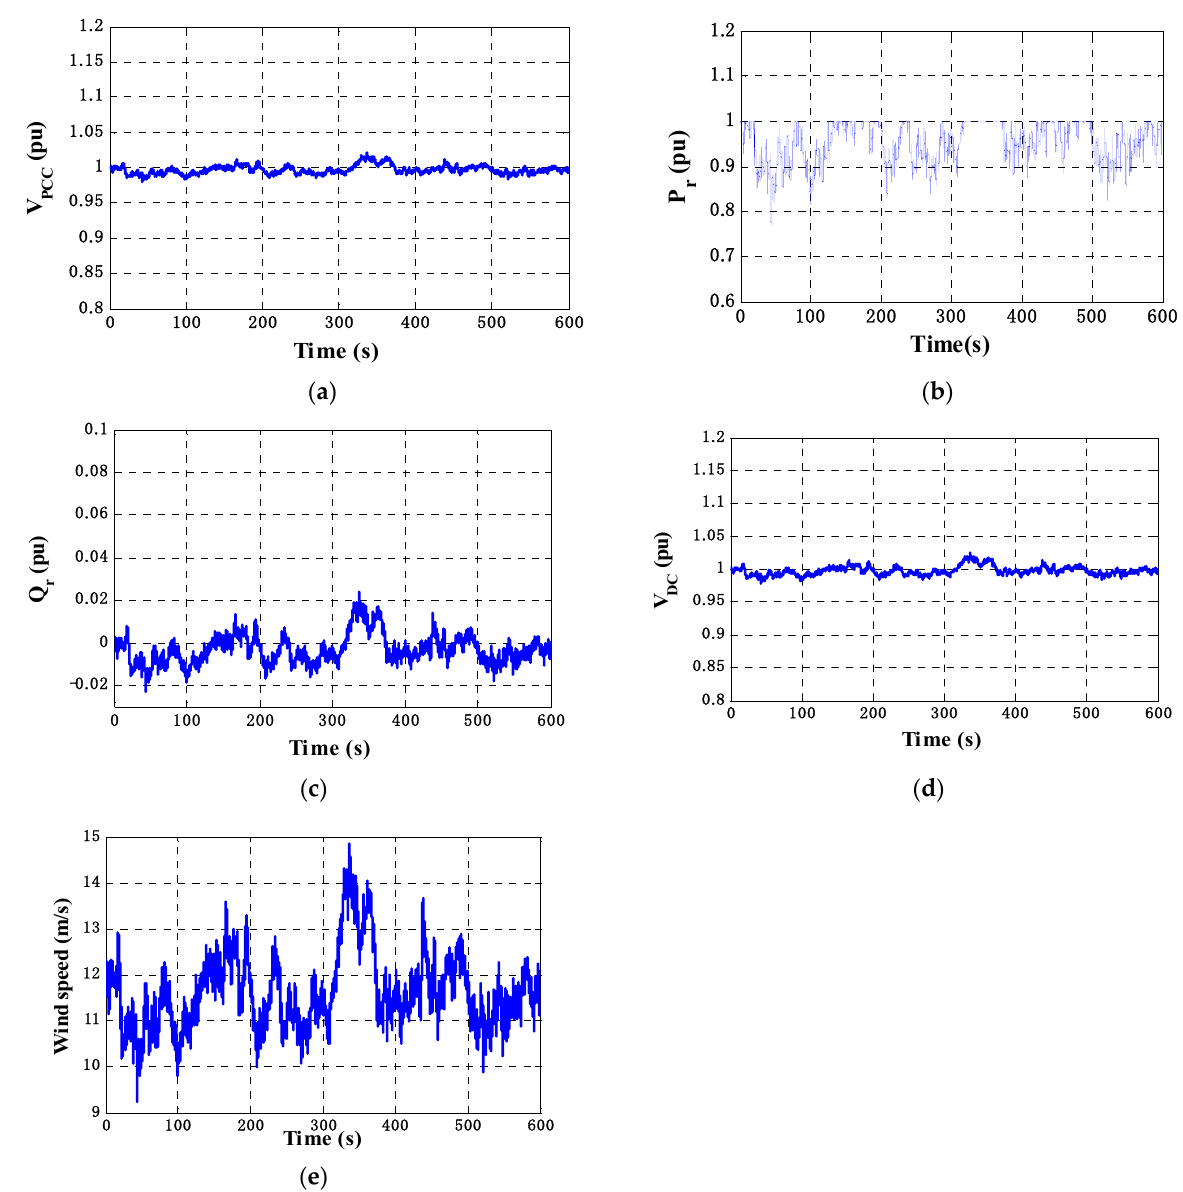
Figure 15. Simulation curves for normal system conditions: ( a ) terminal voltage curve; ( b ) P curve; ( c ) Q curve; ( d ) DC link voltage curve; ( e ) wind speed.